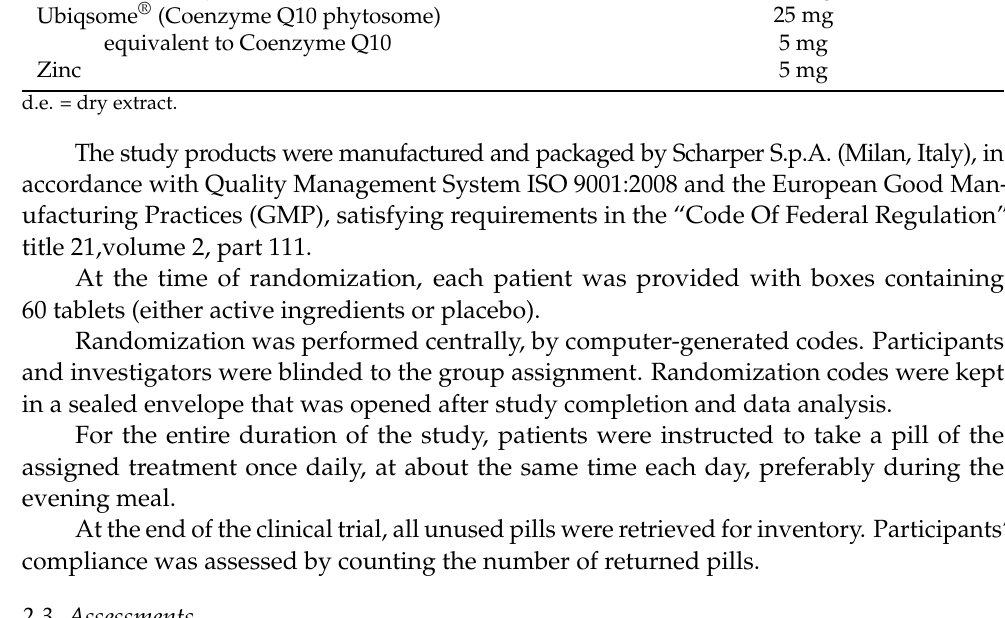
Table 1. Quantitative composition of the active treatment, namely Eufortyn ® Colesterolo Plus, tested in the clinical study. Ingredients Quantity per Tablet Vazguard ® (Phytosome Bergamot Polyphenolic fraction) 1000 mg Pycrinil ® artichoke d.e. ( Cynara cardunculus L.) 100 mg Artichoke d.e. ( Cynara scolymus L.) 20 mg Ubiqsome ® (Coenzyme Q10 phytosome) 25 mg equivalent to Coenzyme Q10 5 mg Zinc 5 mg d.e. = dry